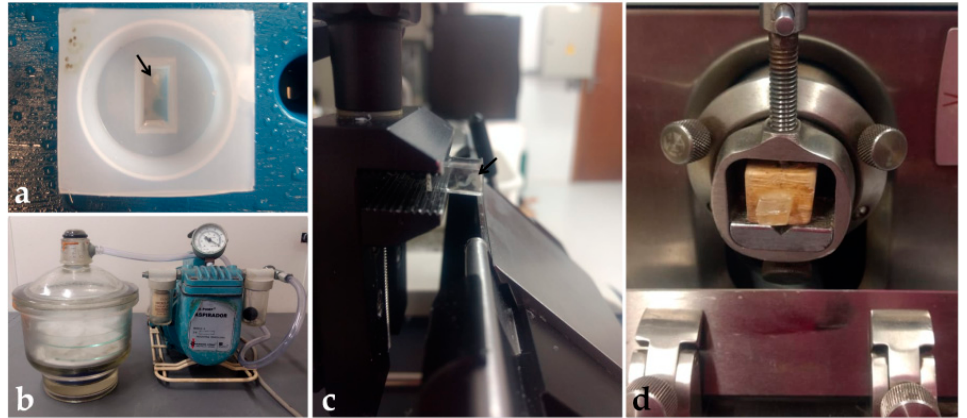
Figure 5. Historesin processing: ( a ) Embryo embedded into the polyethylene mold. ( b ) Desiccator and vacuum pump. ( c ) Block placed in the semi-automatic microtome showing the side view of the transparent block and the blade. ( d ) Block fixed on wood and positioned in the manual microtome. Black arrow: